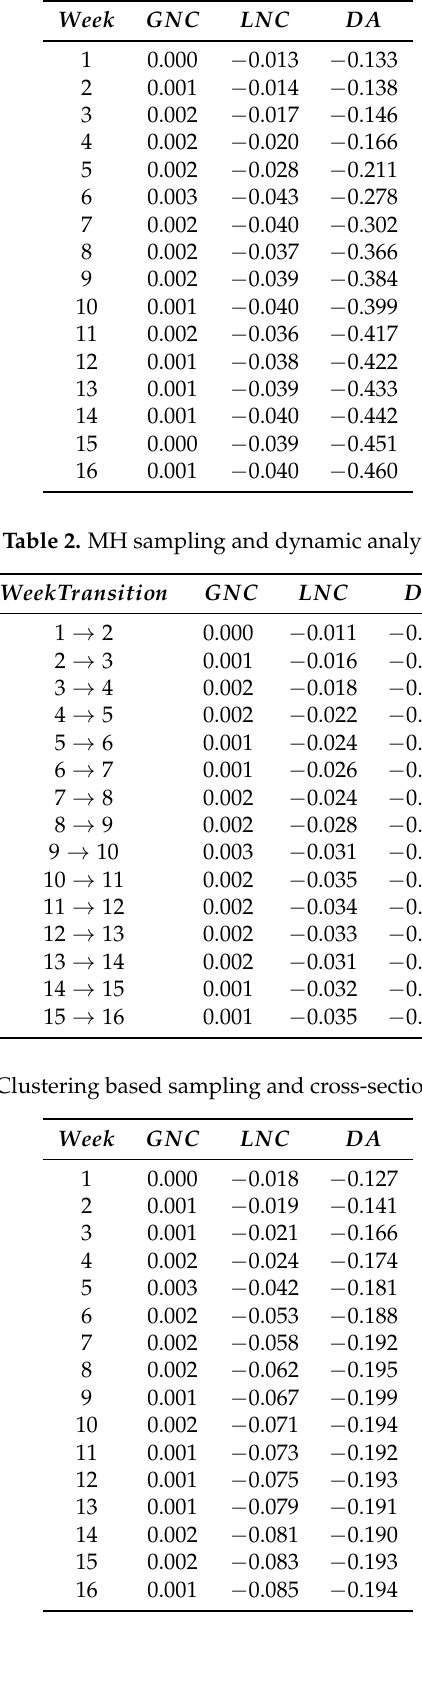
Table 1. MH sampling and cross-sectional analysis.